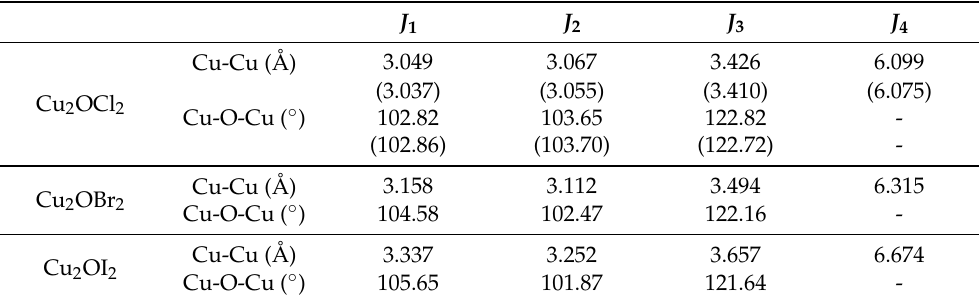
Table 2. Geometrical parameters related to the four magnetic couplings for the Cu 2 OX 2 compounds (X = Cl, Br, I) deduced from DFT+U relaxation ( U e f f [ Cu ( 3 d )] = 6.5 eV). The experimental data of Cu 2 OCl 2 taken from Ref. [11] are given in parentheses.